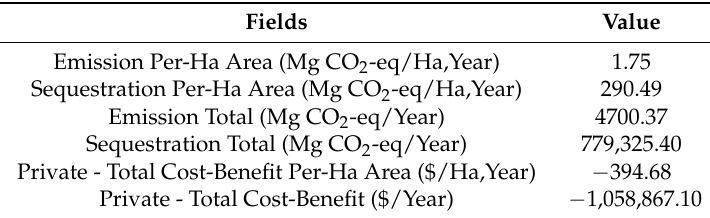
Table A4. Abatement cost curve obtained from REDD+ Abacus